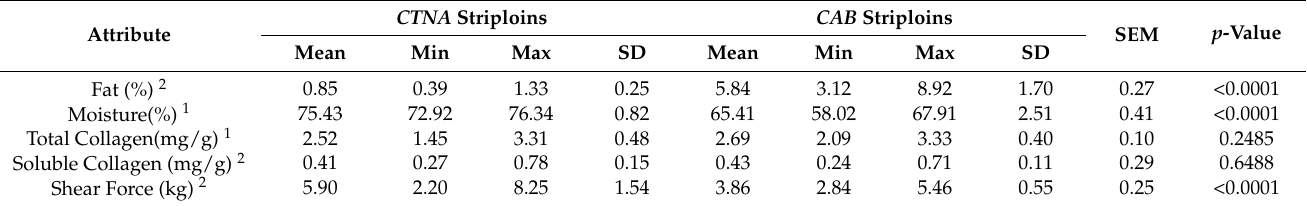
Table 2. Descriptive statistics and mean comparison for physicochemical traits of striploins derived from PGI-Certified Ternera de Navarra ( CTNA ) and Certified Angus Beef ( CAB ), respectively.